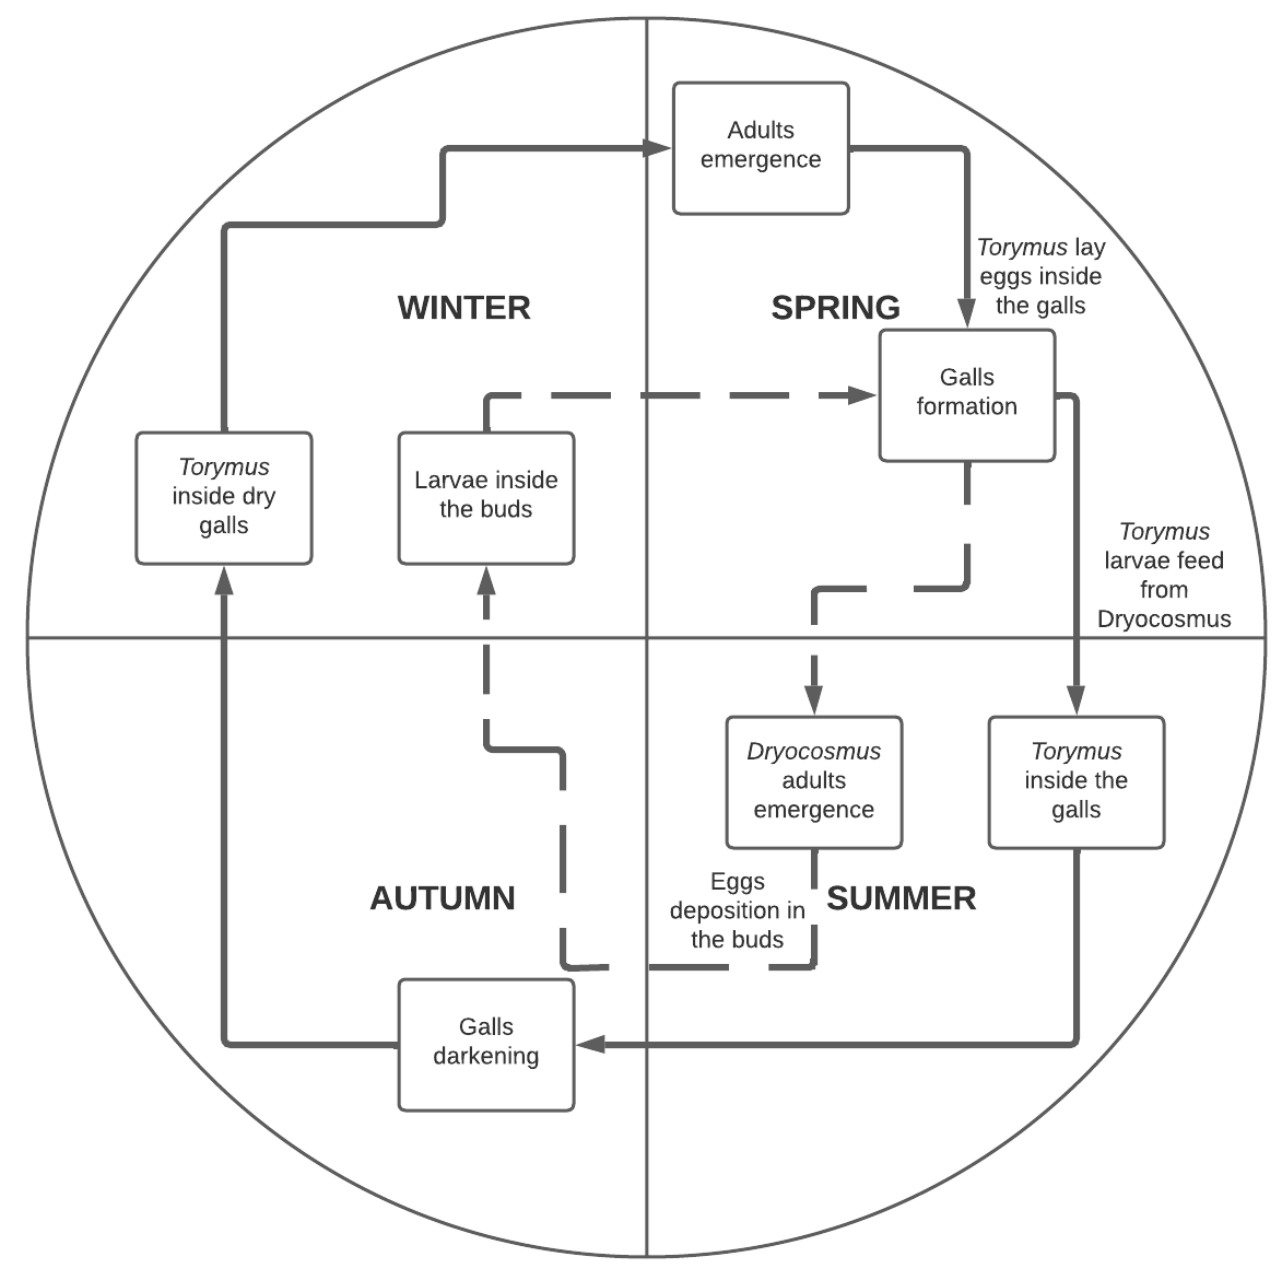
Figure 1. Biological life cycle of Dryocosmus kuriphilus and Torymus sinensis (adapted from [20] ).